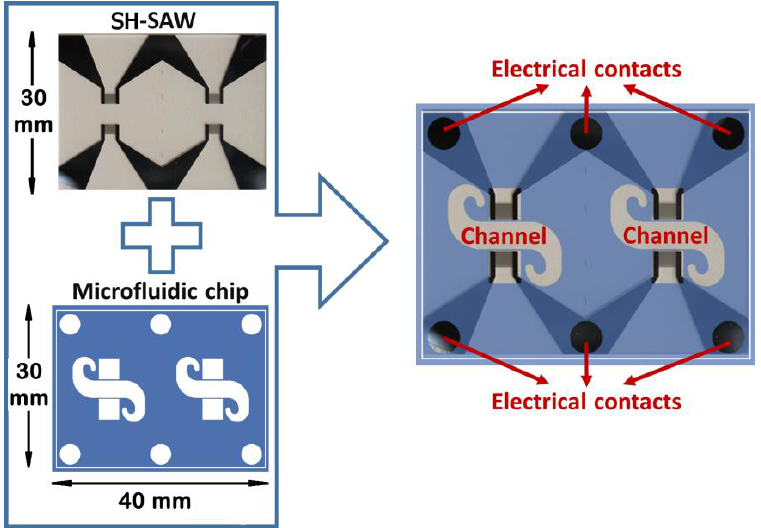
Figure 1. Devices (SH-SAW) plus PDMS microfluidic chip with the microchannel shape.